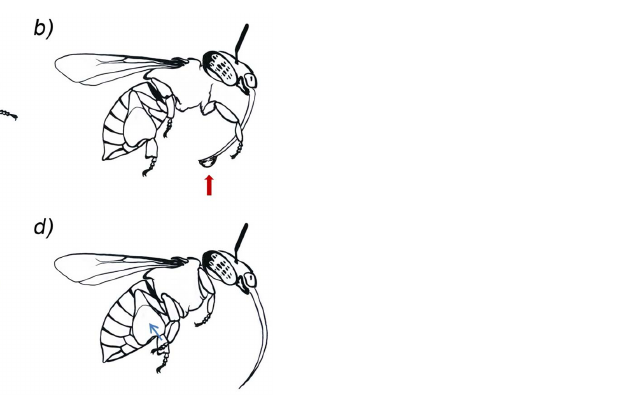
Figure 3. Additional moistening of pollen provisions. Schematic rendering of four video stills (from Video S2) depicting the addition of a regurgitated droplet of sugar-water to the pollen provision carried on the corbiculae while hovering. a) Placement of both front basitarsi at the base of the outstretched proboscis. Basitarsi are thereafter pulled downward to the tip of the proboscis in one swiping movement. b) Appearance of a droplet at the tip of the proboscis. c) Uptake of the droplet with the front tarsi and subsequent relocation to the middle tarsi. d) Transfer of the droplet from the middle tarsi to the pollen provisions by moving them upward from the hind basitarsi.